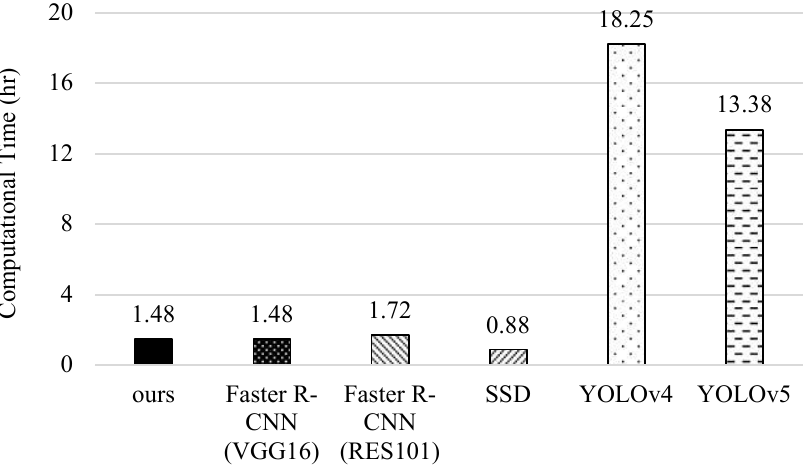
Figure 18. Comparison of the computational complexity of different methods.